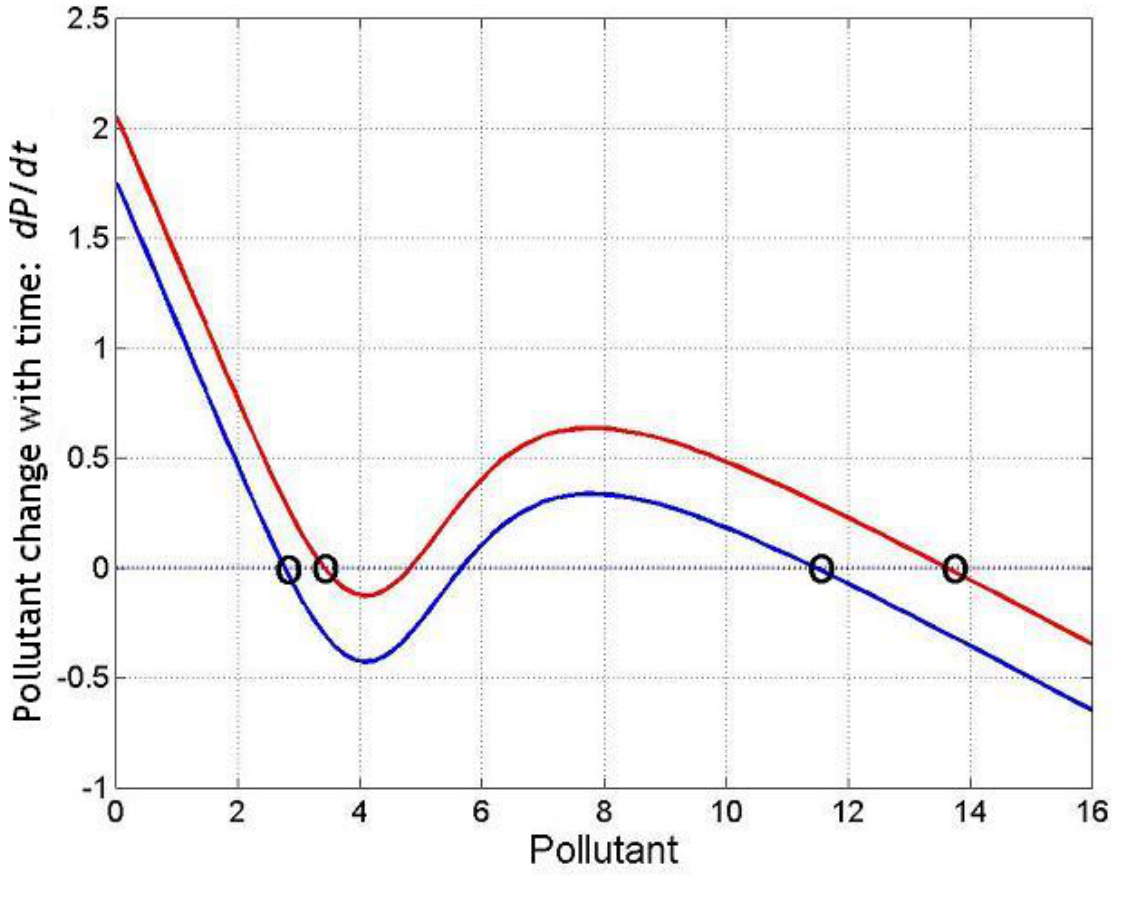
Fig. 3 . Net rate of change for a single region vs. pollutant level for two rates of input to region 1. Blue: the pollution rate for region 1 ( M ) = 1.6; red: M = 1.9). Circles denote stable points. The pollutant level 1 1 in the other region was fixed at 1.6. Other parameters: M (the pollution rate in region 2) = 0.75; D (the 2 transport rate between regions) = 0.1; c (the decay rate) = 0.05; s (the maximum sequestration rate) = 0.5; m (the pollutant level at which sequestration is half the maximum rate) = 5; q (which determines the slope of f(P) near P ) = 6. P stands for amount of pollutant, and f(P) scales the sequestration to the amount of